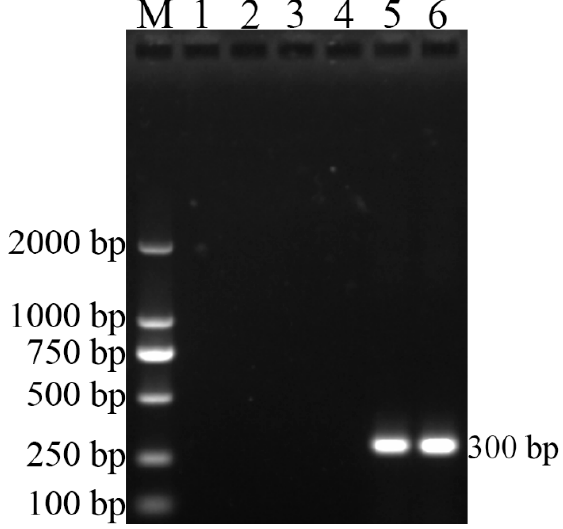
Figure 2. BcSS-PCR results of the four reference strains and the isolate in this study (CD3). Lane M, molecular weight marker; Lane 1, negative control with no DNA added; Lane 2, DNA extracted from B. abortus (544A); Lane 3, DNA extracted from B. melitensis (16M); Lane 4, DNA extracted from B. suis (S2); Lane 5, DNA extracted from B. canis (RM6/66); Lane 6, DNA extracted from the isolated strain (CD3). Table 3. Results of two PCR assays of all five strains used in this study.